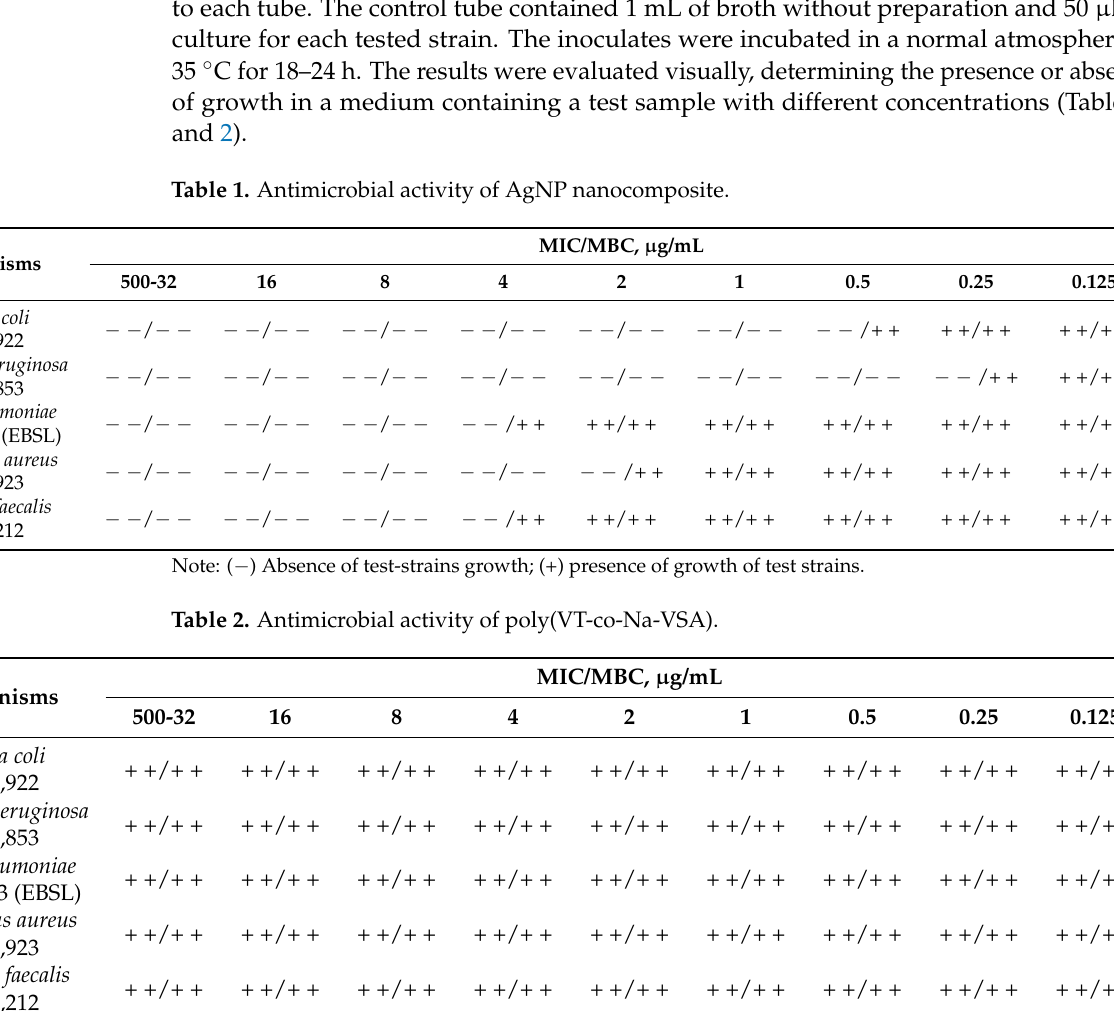
Table 1. Antimicrobial activity of AgNP nanocomposite.